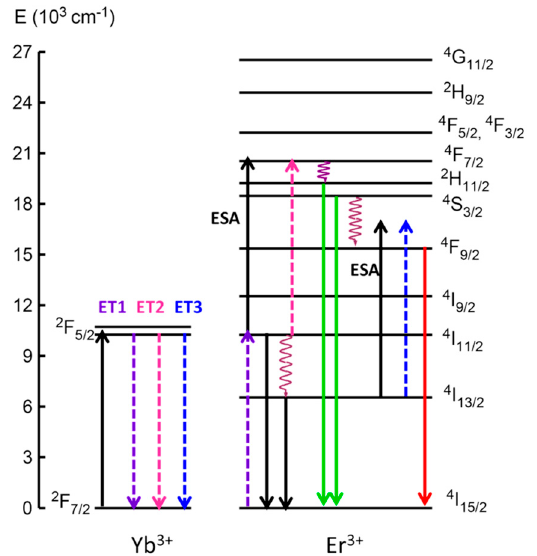
Figure 8. Energy level diagram of Er 3 + and Yb 3 + ions with the main emissions indicated by solid downwards-pointing arrows. Up-conversion (UC) mechanisms (energy transfer (ET), excited-state absorption (ESA) or energy-transfer up-conversion (ETU)) are also indicated.